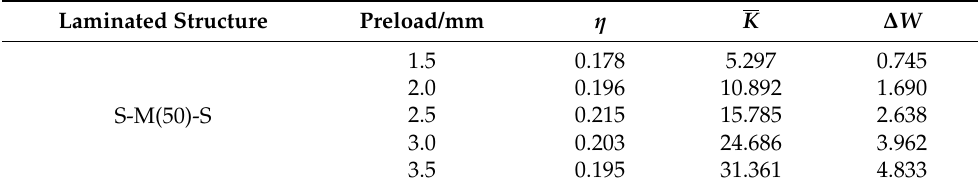
Table 10. Dynamic parameter variation with preload.